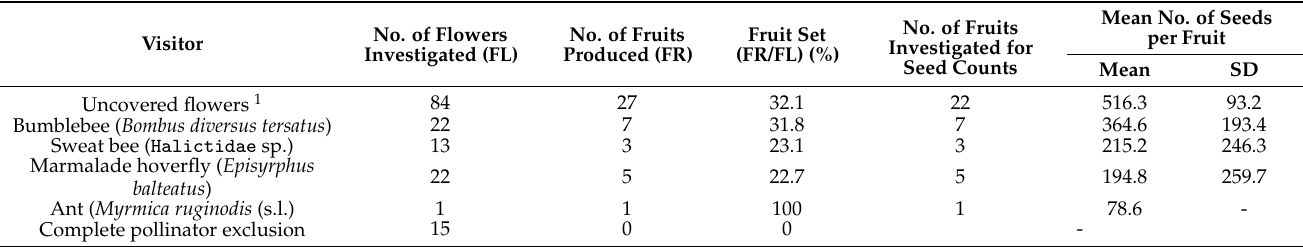
Table 4. Pollination contribution of each species, estimated as the total number of seeds in each fruit produced after a single visit of each individual insect, with the prior exclusion and subsequent exclusion of the other visitors by covering the flowers with